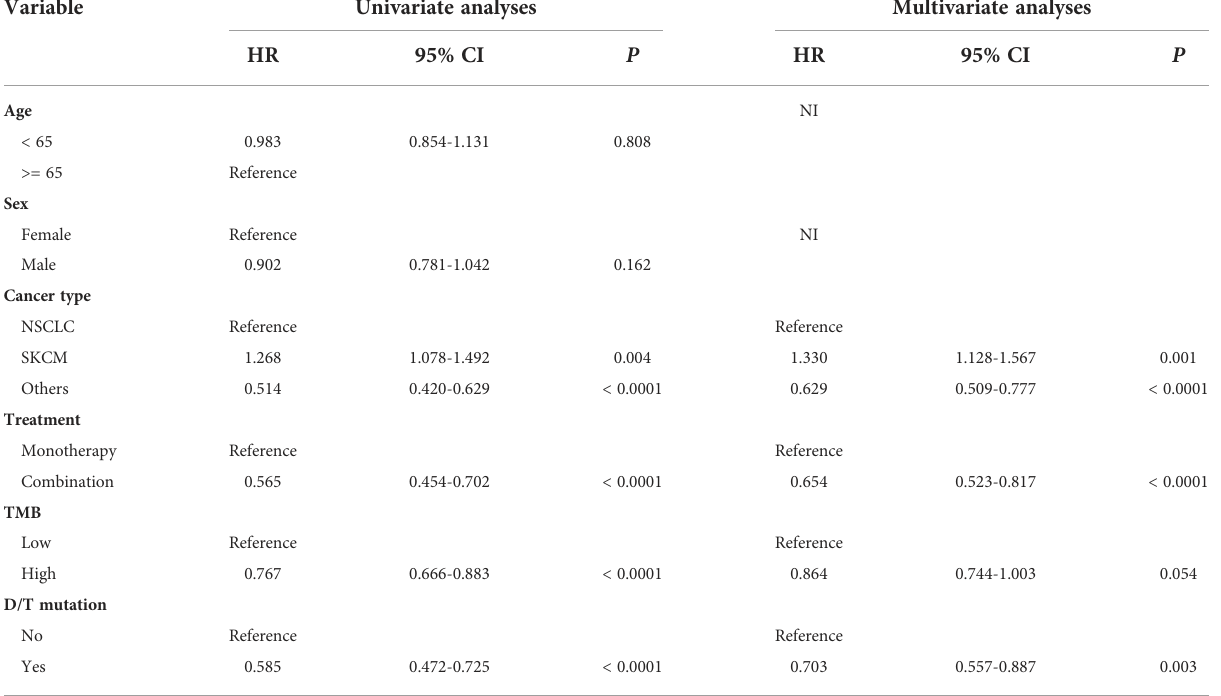
TABLE 2 Univariate and multivariate analyze Cox regression in ICI-treated cohort (Samstein et al.).